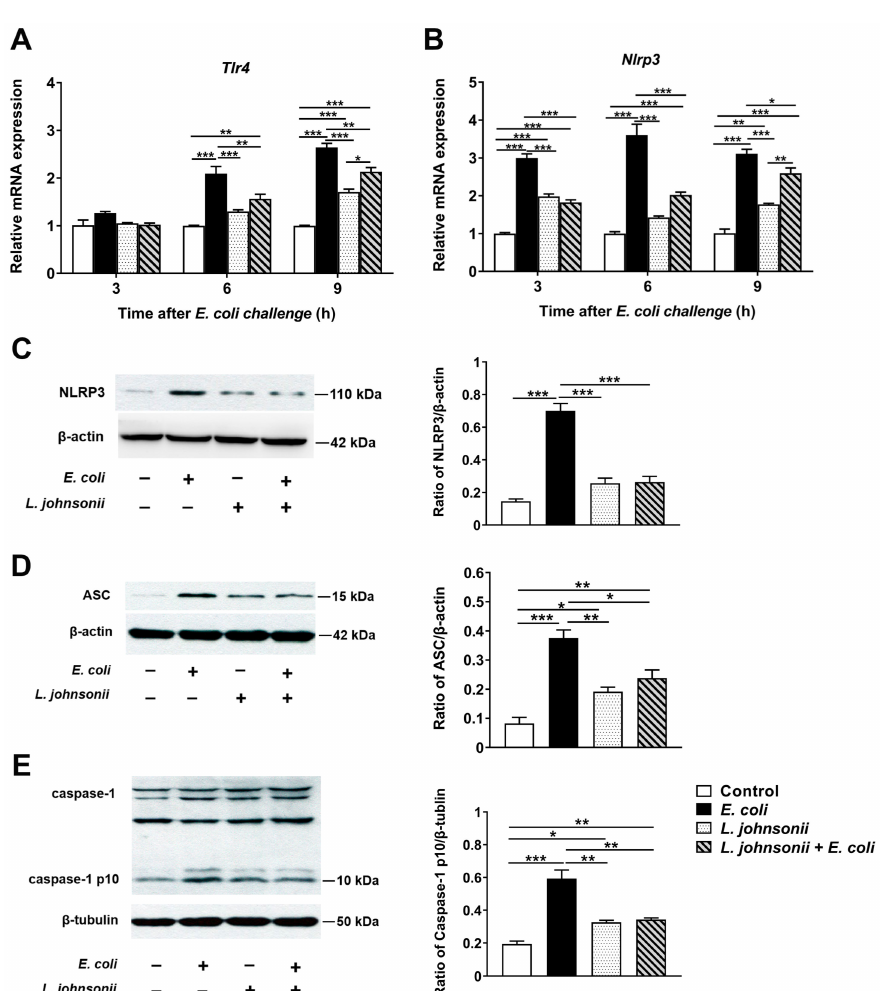
Figure 3. Pretreatment with L. johnsonii L531 inhibited E. coli -induced NLRP3 inflammasome activation. The mRNA expression of Tlr4 ( A ) and Nlrp3 ( B ) genes obtained from the indicated PMECs at 3, 6, 9 h post-infection was analyzed by quantitative real-time PCR. Western blotting analysis of NLRP3 ( C ), ASC ( D ), and caspase-1 ( E ) expression in PMECs at 6 h after challenge with E. coli or cells pre-incubated with L. johnsonii L531 for 3 h before E. coli infection. Data were presented as the mean ± SEM of three independent experiments. * p < 0.05; ** p < 0.01; *** p <